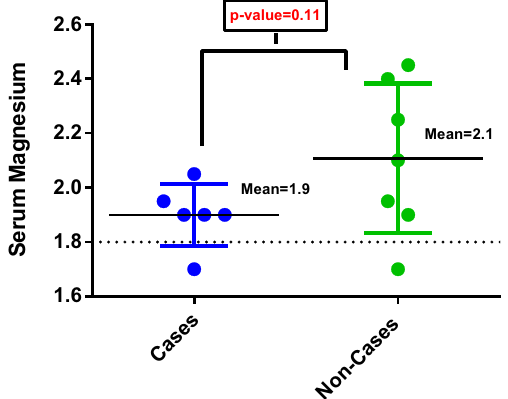
Figure 1. Legend: Magnesium levels among NPC cases and unaffected family members from two NPC multiplex families with NIPAL1